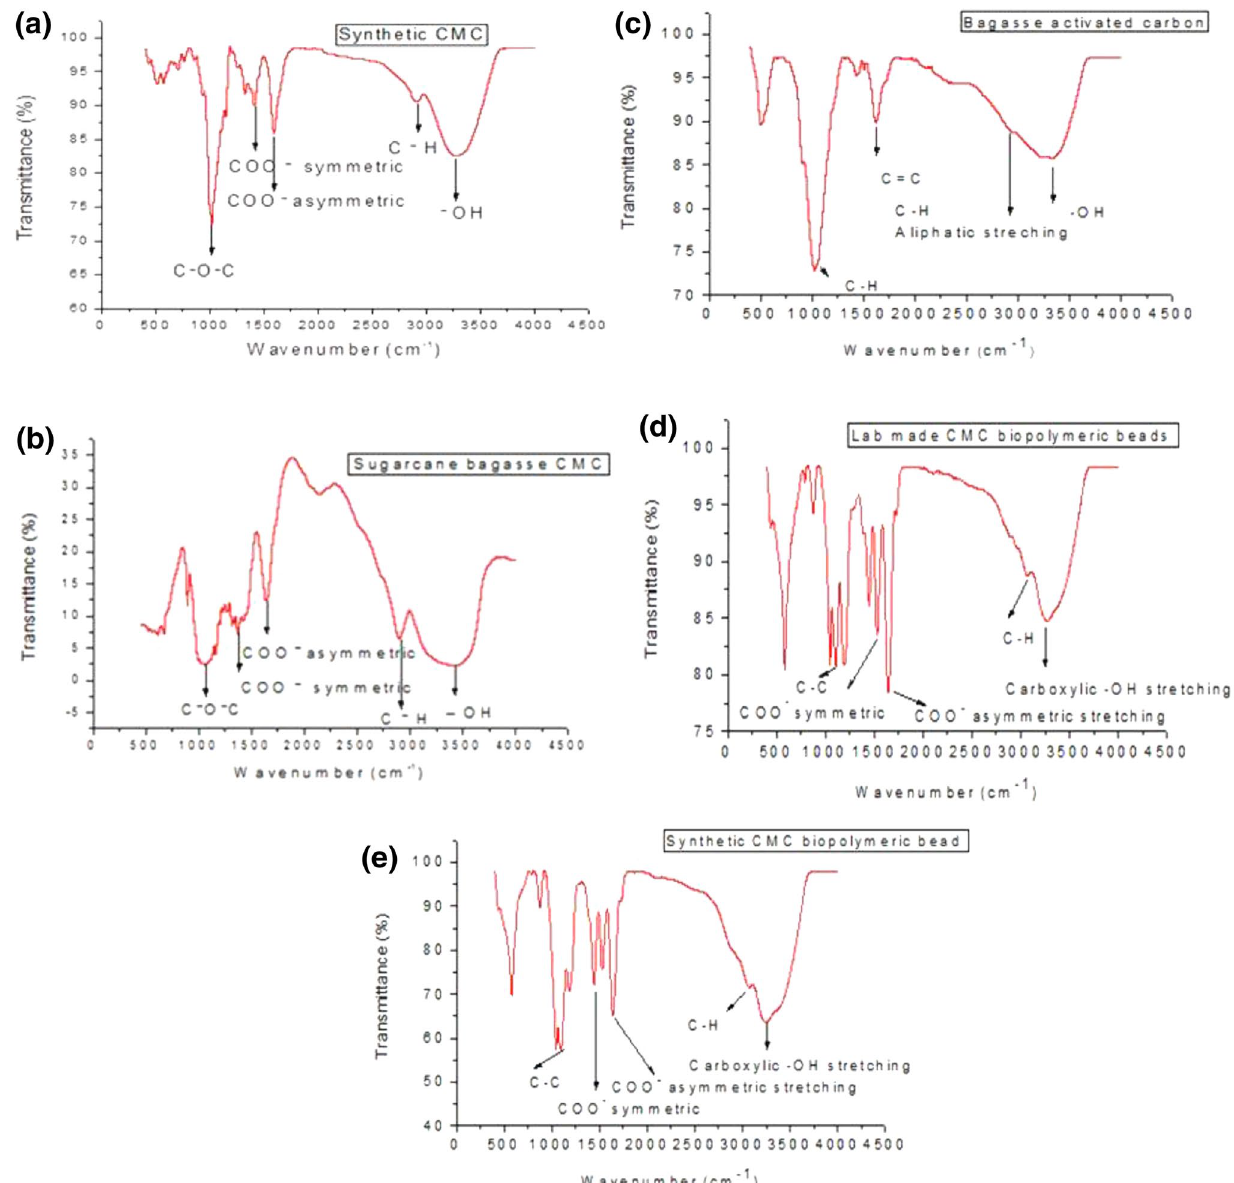
Fig. 5 a FTIR spectra of synthetic CMC, b FTIR spectra of bagasse CMC, c FTIR spectra of bagasse activated carbon, d FTIR spectra of bio- polymeric beads of bagasse CMC and e FTIR spectra of bio-polymeric beads of synthetic